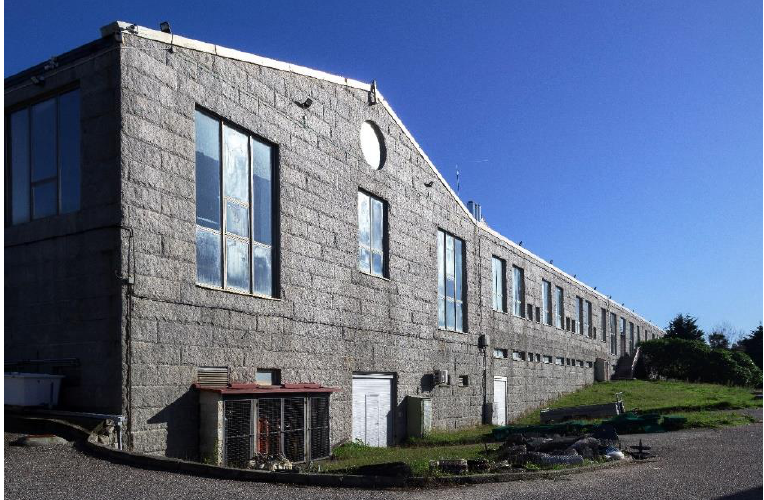
Figure 4. Galician Institute for Aquaculture Training (IGaFA) in Niño do Corvo (Arousa island,